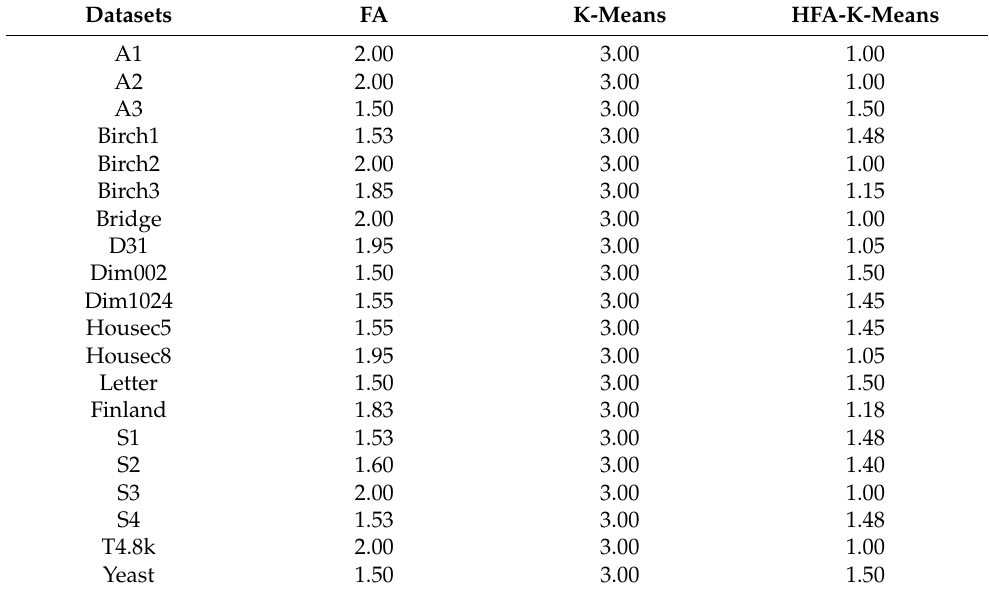
Table 10. Friedman rank-sum test for the HFA-K-means and the two classical algorithms tested across the twenty datasets for the twenty algorithm runs.